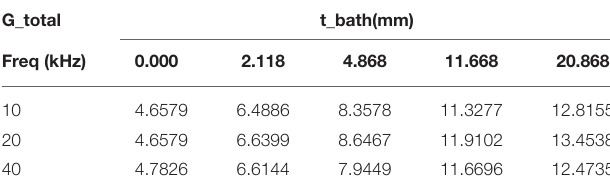
FIGURE 2 | (A) Predicted lumen diameter vs. optically measured for the 11 in vitro tests with the line of equality. (B) Bland-Altman chart for the 11 in vitro tests. TABLE 3 | Variation of total conductance with respect to the bath